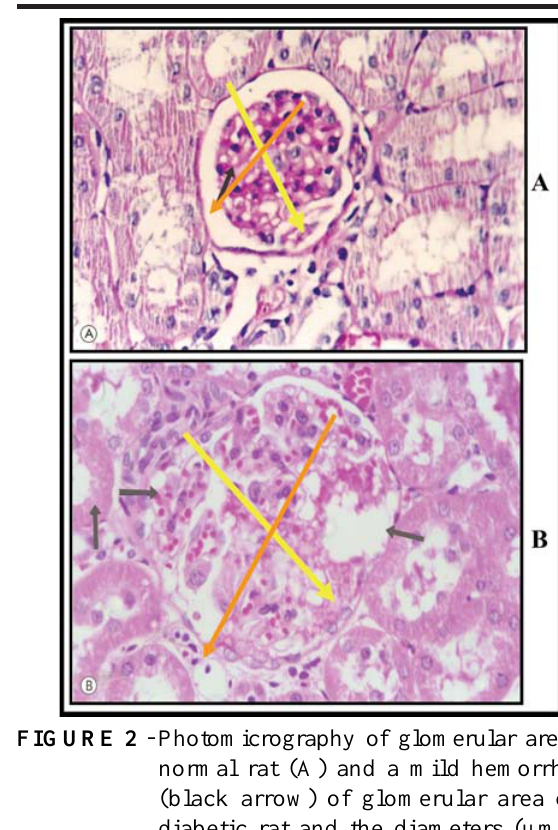
FIGURE 2 - Photomicrography of glomerular area of normal rat (A) and a mild hemorrhage (black arrow) of glomerular area of a diabetic rat and the diameters (µm) of Bowman capsule (yellow arrow) and glomerulus (orange arrow). (H&E -200X)